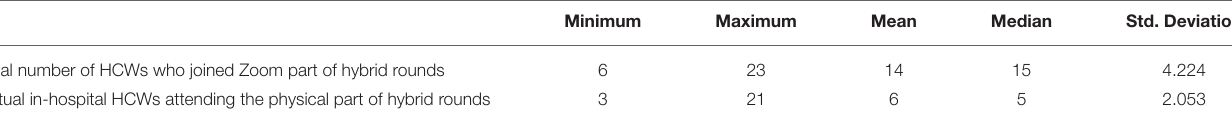
TABLE 2 | Total number of HCWs who joined the Zoom part of the hybrid PICU round and the actual HCWs who joined the subsequent physical round. Minimum Maximum Mean Median Std.